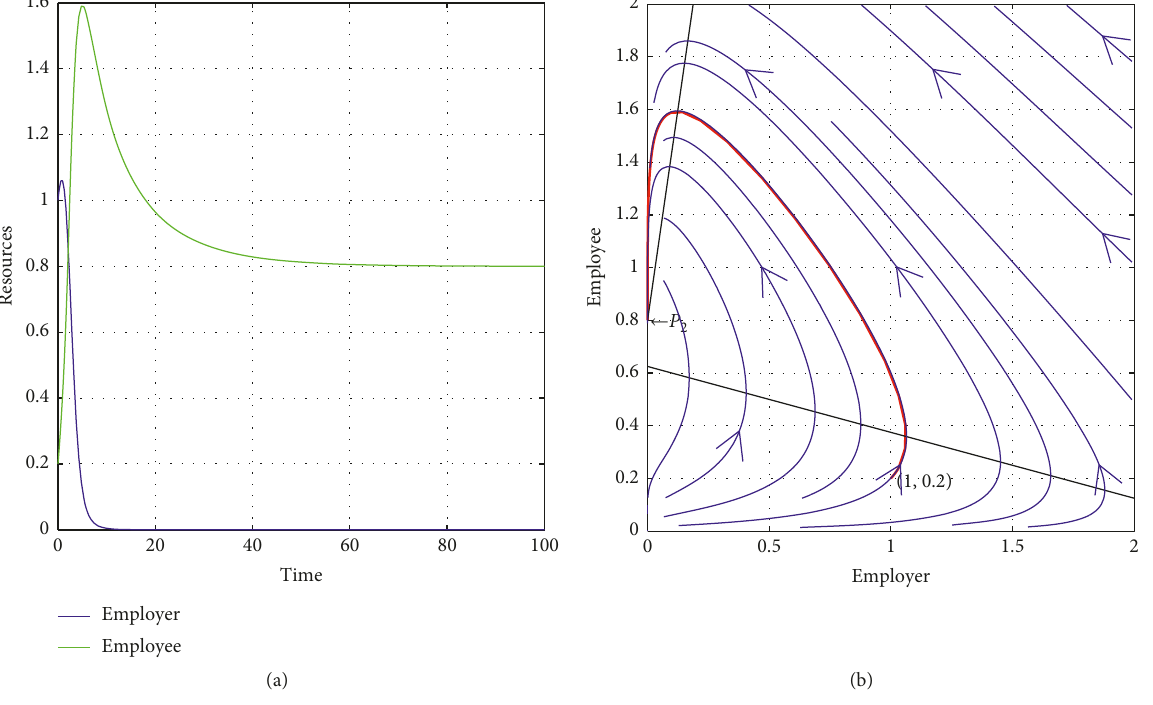
Figure 4: The simulation result and the phase diagram in the employee win